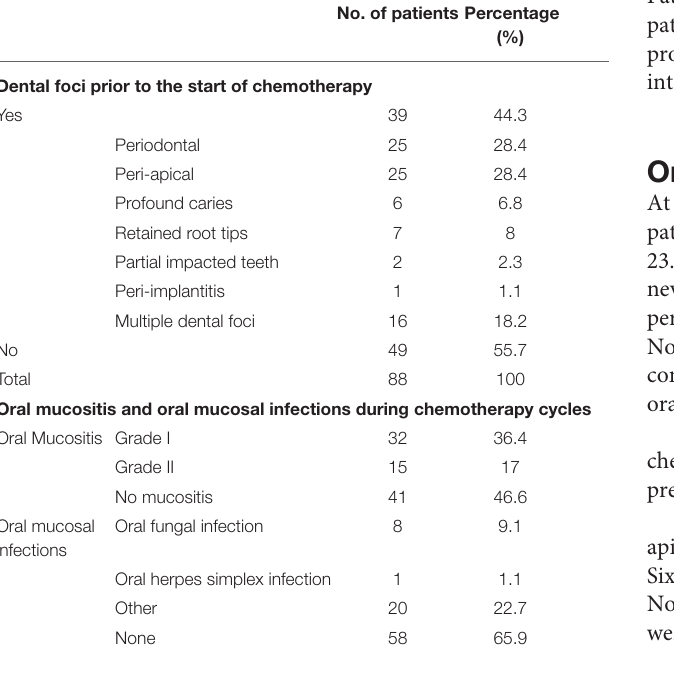
TABLE 3 | Dental foci pre-chemotherapy, oral mucositis and oral mucosal infections during the course of chemotherapy ( N = 88).